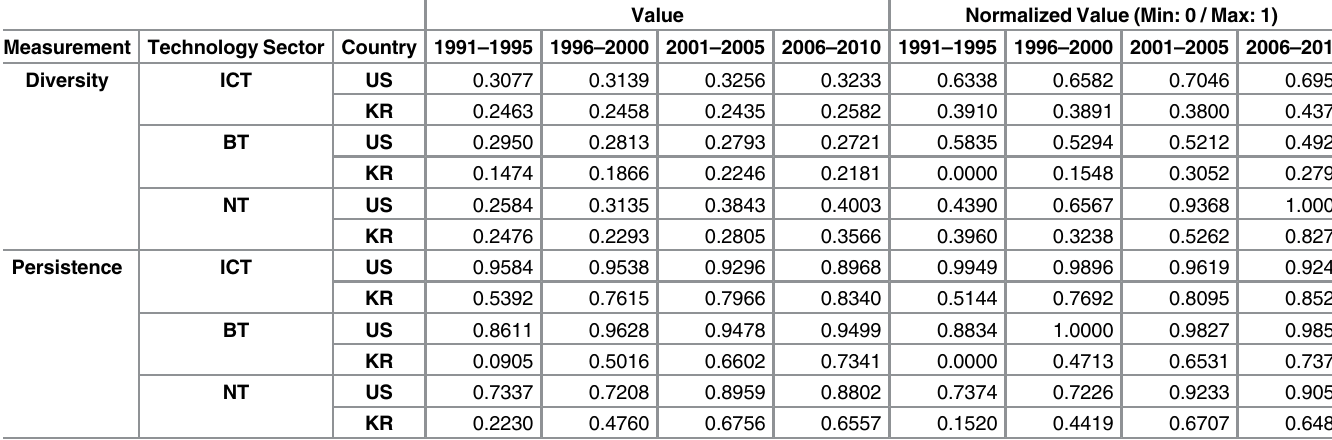
Table 12. Diversity and Persistence Values and Normalized Values in ICT, BT, and NT Sectors between the US and Korea. Value Normalized Value (Min: 0 / Max: